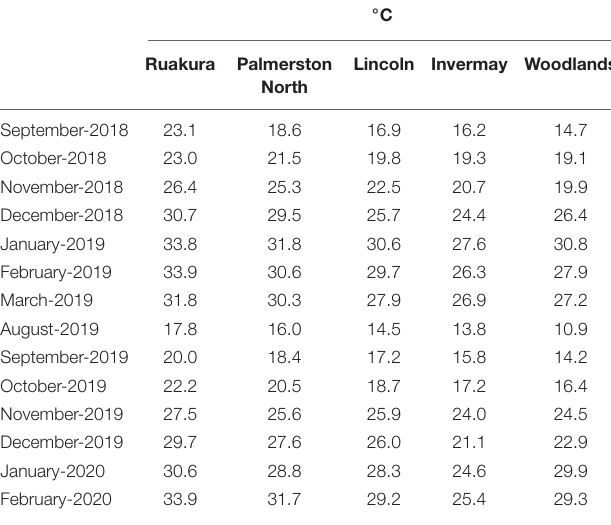
TABLE 3 | Average monthly temperatures at the experimental